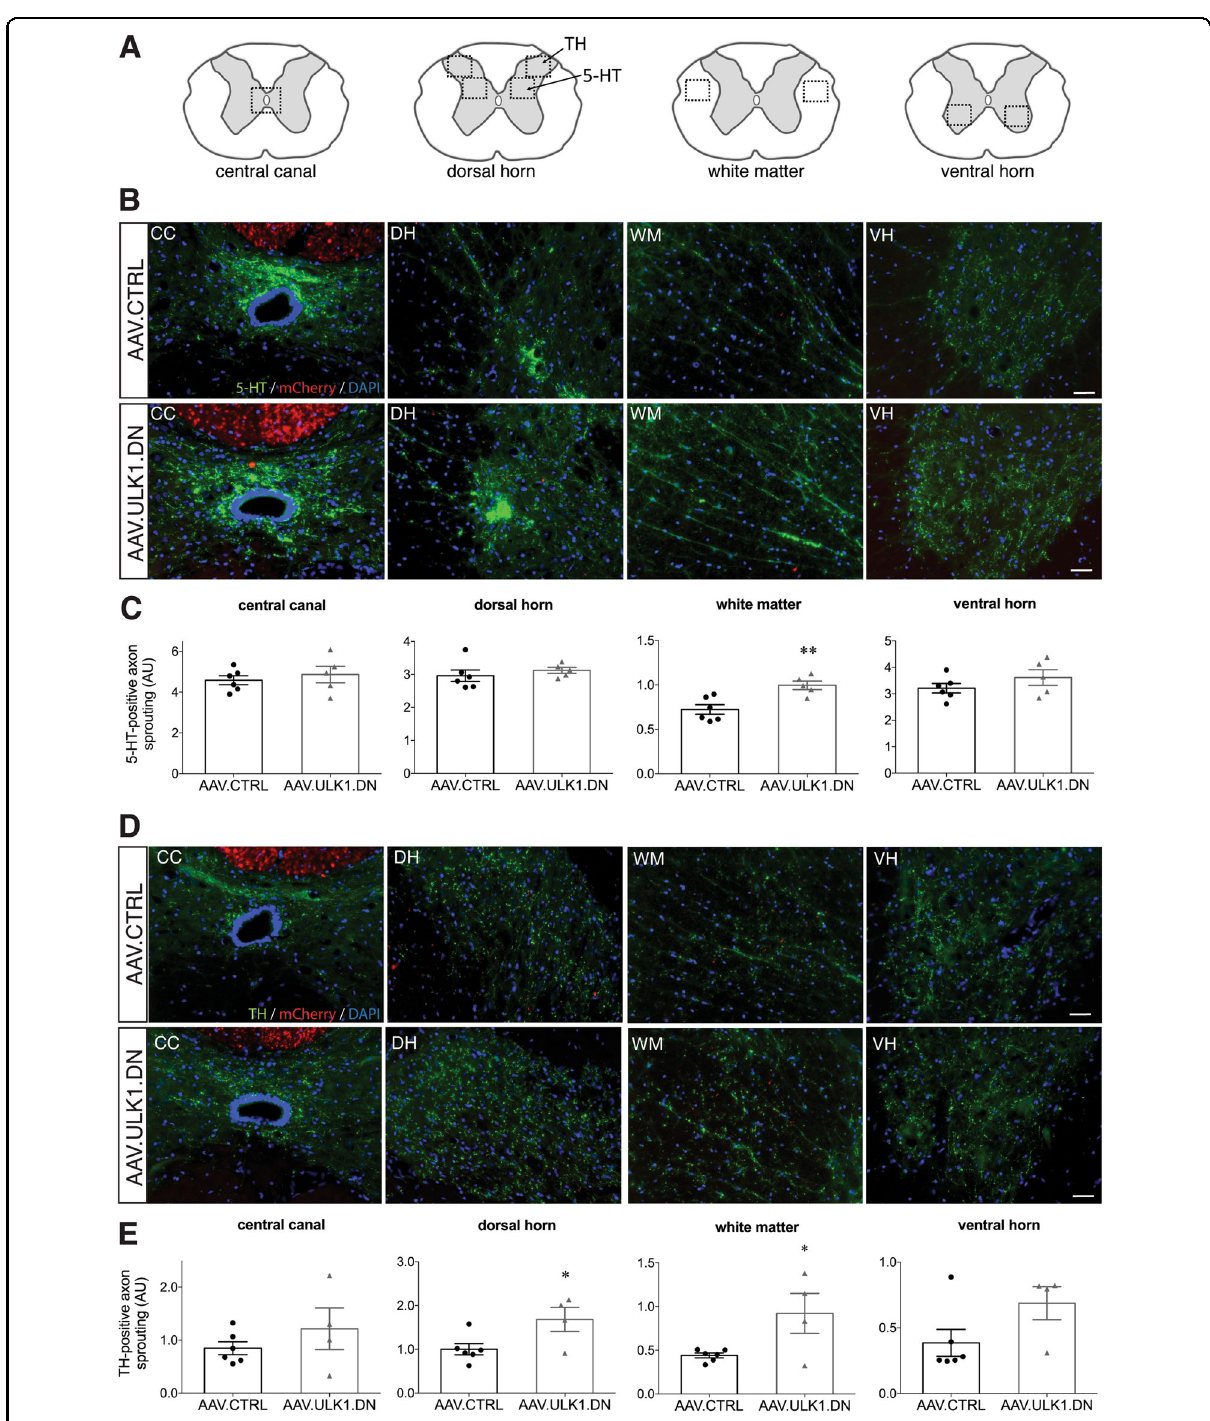
Fig. 6 AAV.ULK1.DN promotes axon sprouting after spinal cord injury. A Schematic overview of areas used for the quanti fi cation of axon sprouting rostral to the lesion at cervical level C2. B , D Representative images of coronal spinal cord sections (C2) transduced with given AAV showing mCherry-positive axons (red) and staining for 5-HT ( B -green), TH ( D -green) and DAPI (blue). CC: central canal; DH: dorsal horn; WM: white matter; VH: ventral horn. Scale bar: 100 μ m. C , E Quanti fi cation of 5-HT ( C ) and TH ( E ) axon sprouting after transduction with AAV.CTRL ( n = 6 animals) and AAV.ULK1.DN ( n = 4 animals). AU: arbitrary units. Data are presented as single data points and means ± SEM. * P < 0.05, according to two-tailed unpaired t